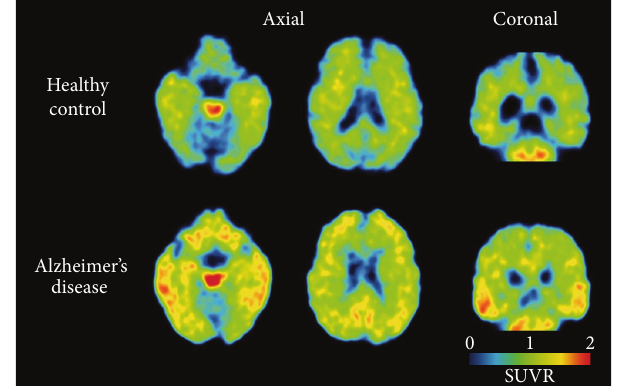
Figure 2: 18 F-THK5105 PET images from 60 to 80 min after injection in a healthy control subject (72 years old, CDR 0, MMSE 29) and a patient with Alzheimer’s disease (68 years old, CDR 1.0, MMSE 20). Reproduced from [23] with permission, copyright 2014 Oxford University